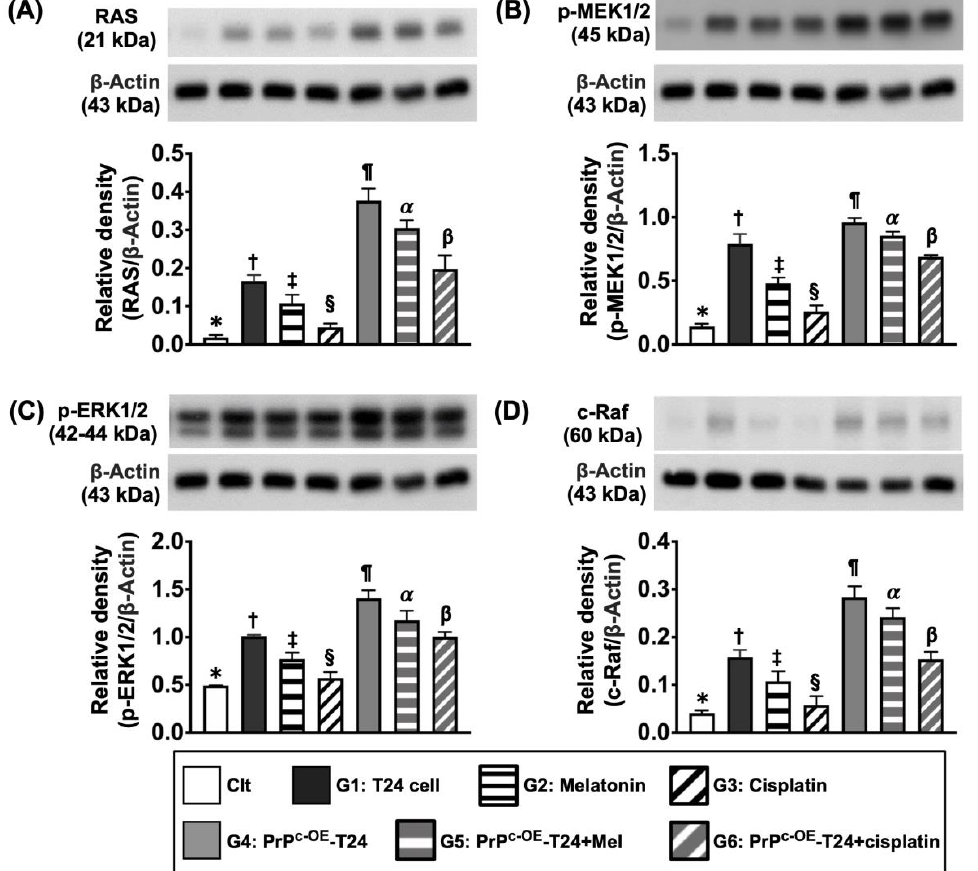
Figure 6. Protein expressions of cell stress signaling in different situations. ( A ) Protein level of RAS: (1) * vs. different symbols (†, ‡, and §) and (2) ¶ vs. different symbols ( α and β ), all p values < 0.0001. ( B ) Protein level of p-MEK1/2): (1) * vs. different symbols (†, ‡, and §) and (2) ¶ vs. different symbols ( α and β ), all p values < 0.0001. ( C ) Protein level of phosphorylated extracellular signal-regulated kinase 1 and 2 (p-ERK1/2): (1) * vs. different symbols (†, ‡, and §) and (2) ¶ vs. different symbols ( α and β ), all p values < 0.0001. ( D ) Protein level of proto-oncogene c-Raf (c-Raf): (1) * vs. different symbols (†, ‡, and §) and (2) ¶ vs. different symbols ( α and β ), all p values < 0.0001. n = 6 for each group. Control (Clt) = V-HUC-1; G1 = T24 only; G2 = melatonin (Mel); G3 = cisplatin; G4 = PrP C overexpression in T24 cells (i.e., PrP C-OE -T24); G5 = PrP C-OE -T24 cells + Mel (100 µ M treated for 24 h); G6 = PrP C-OE -T24 cells + cisplatin (6.0 uM treated for 24